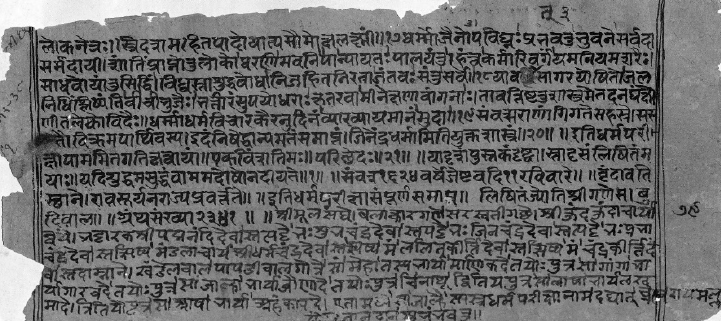
Figure 7. Dharmapar ī k ṣ ā by Amitagati, BORI 1076/1884–87 61 . Figure 7. Dharmapar¯ıks. ¯a by Amitagati, BORI 1076 / 1884–87 61